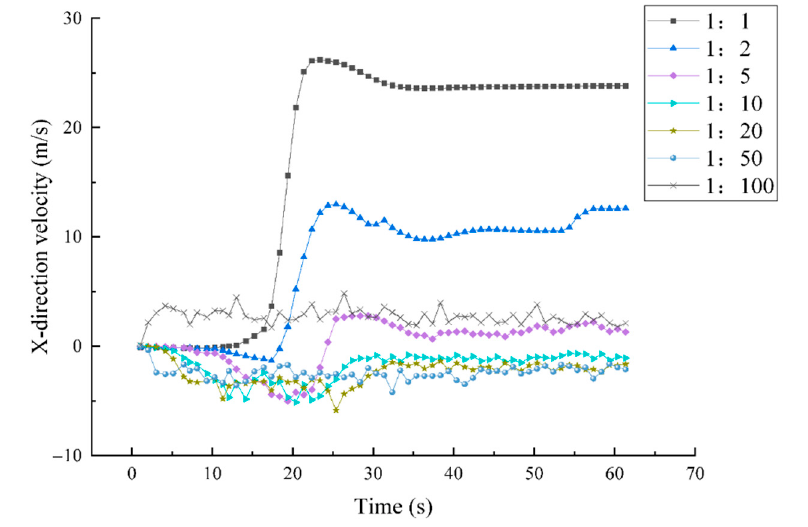
Figure 5. The x-direction component of wind speed under different similarity scales.